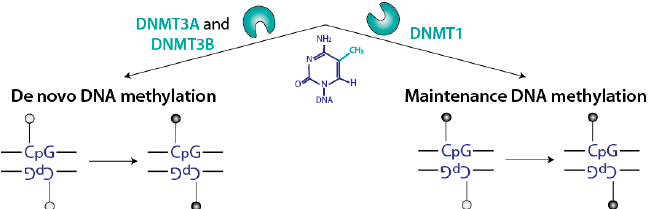
Figure 3. Specificities of the DNMTs DNA methylation can take place in two different contexts, and is processed by two distinct mechanisms: de novo DNA methylation involves fully unmethylated DNA and occurs on both strands, whereas maintenance of DNA methylation involves hemimethylated DNA.